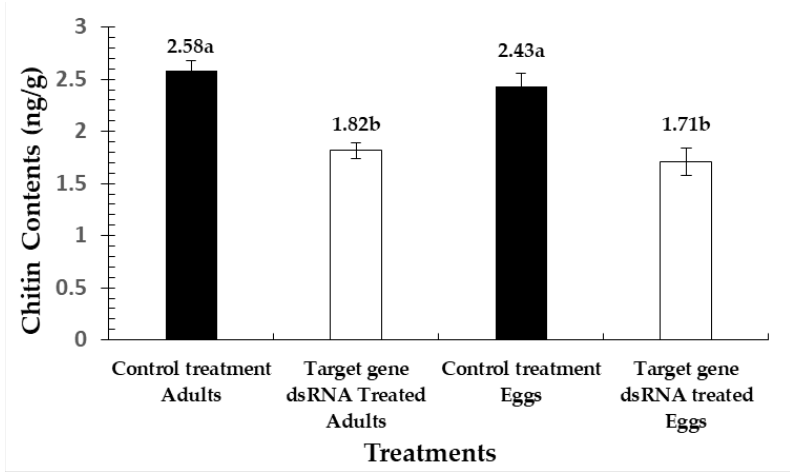
Figure 9. Chitin contents recorded in different developmental stages of P. citri . The values are the means of three biological replicates. Bars represent means and standard errors calculated from three independent replicates. Each replicate was compiled by pooling mites to make a 20 mg sample for analysis. The chitin contents were analyzed by ANOVA, and significant differences among the means were analyzed by a Fisher’s LSD test (α = 0.05). Different small case letters on the bars showing significant difference between the treatments.